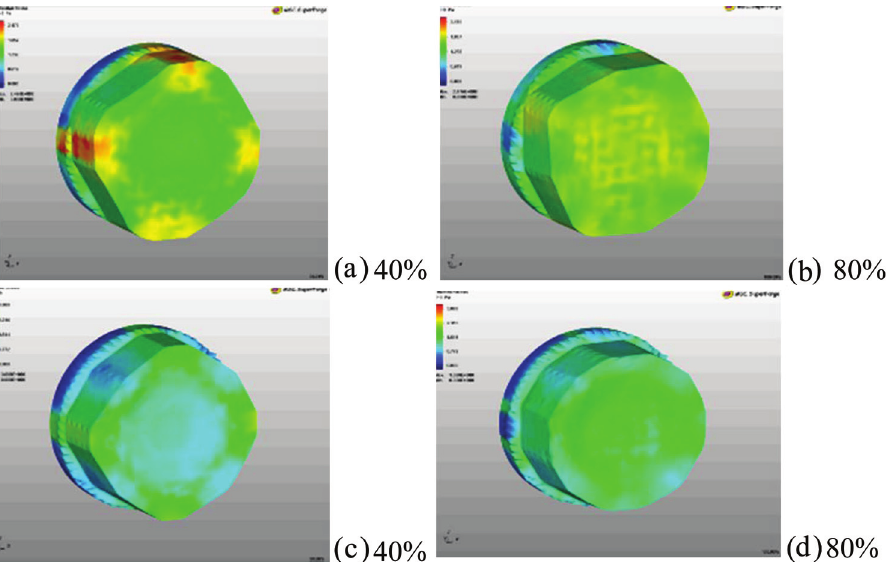
Figure 9: Picture of intensity tension distribution when forging on RFM with angles of rotation 30° (a and b) and 60° (c and d), t ¼ 1,150°C.